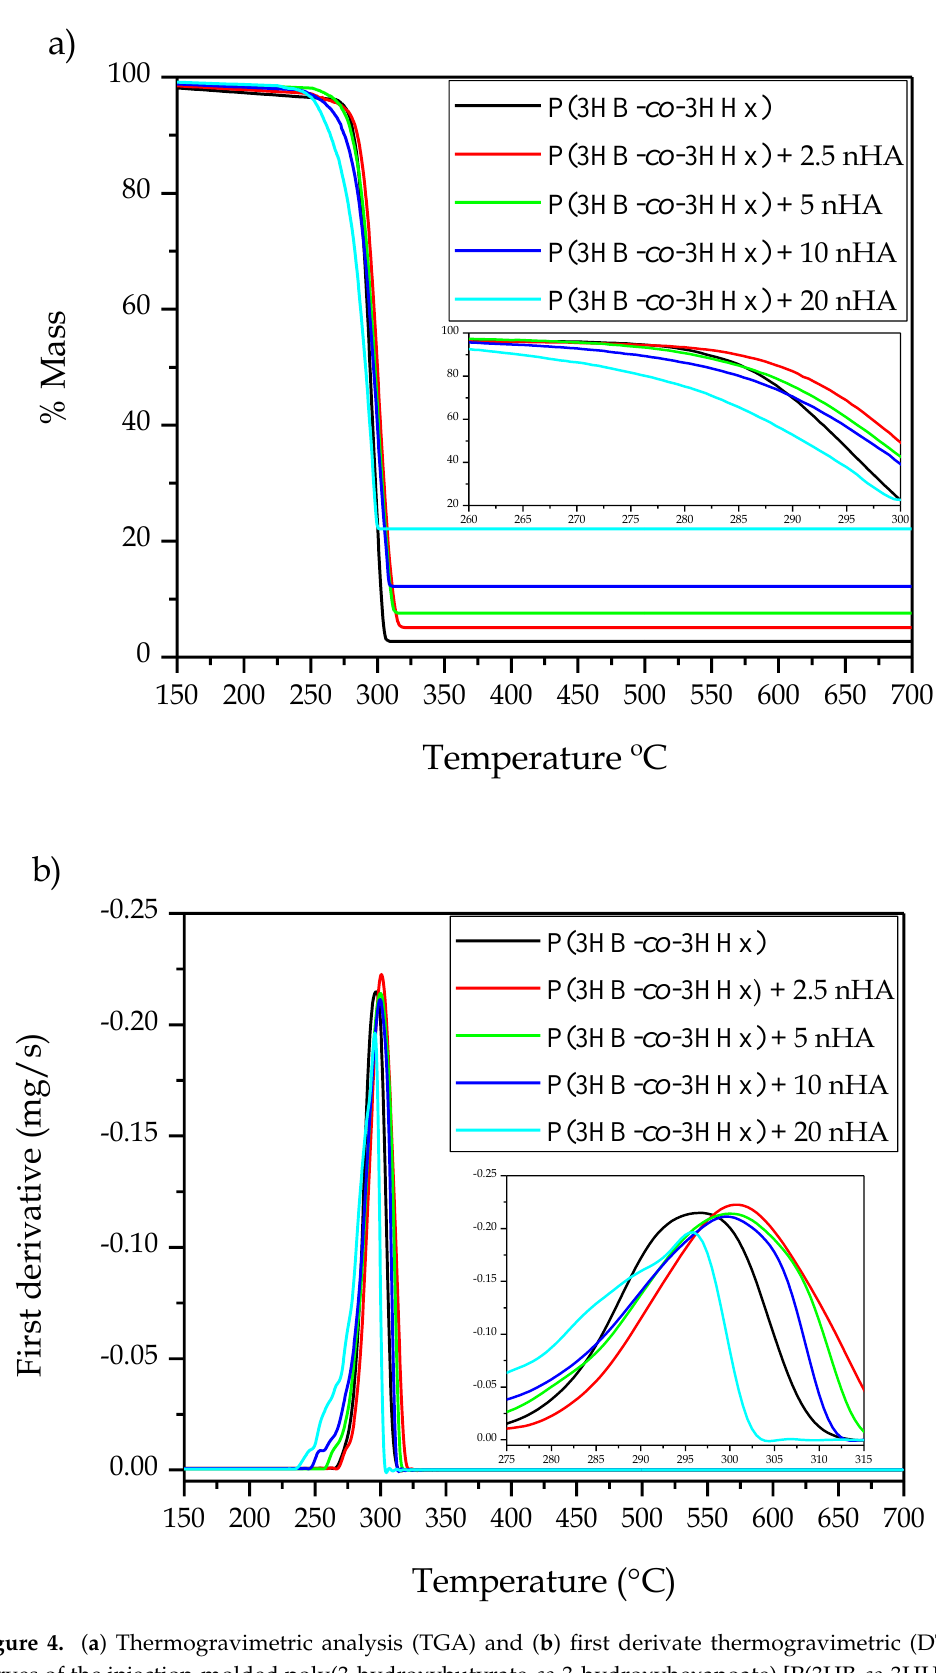
Figure 4. ( a ) Thermogravimetric analysis (TGA) and ( b ) first derivate thermogravimetric (DTG) curves of the injection-molded poly(3-hydroxybutyrate- co -3-hydroxyhexanoate) [P(3HB- co -3HHx)]/hydroxyapatite nanoparticle (nHA) parts.